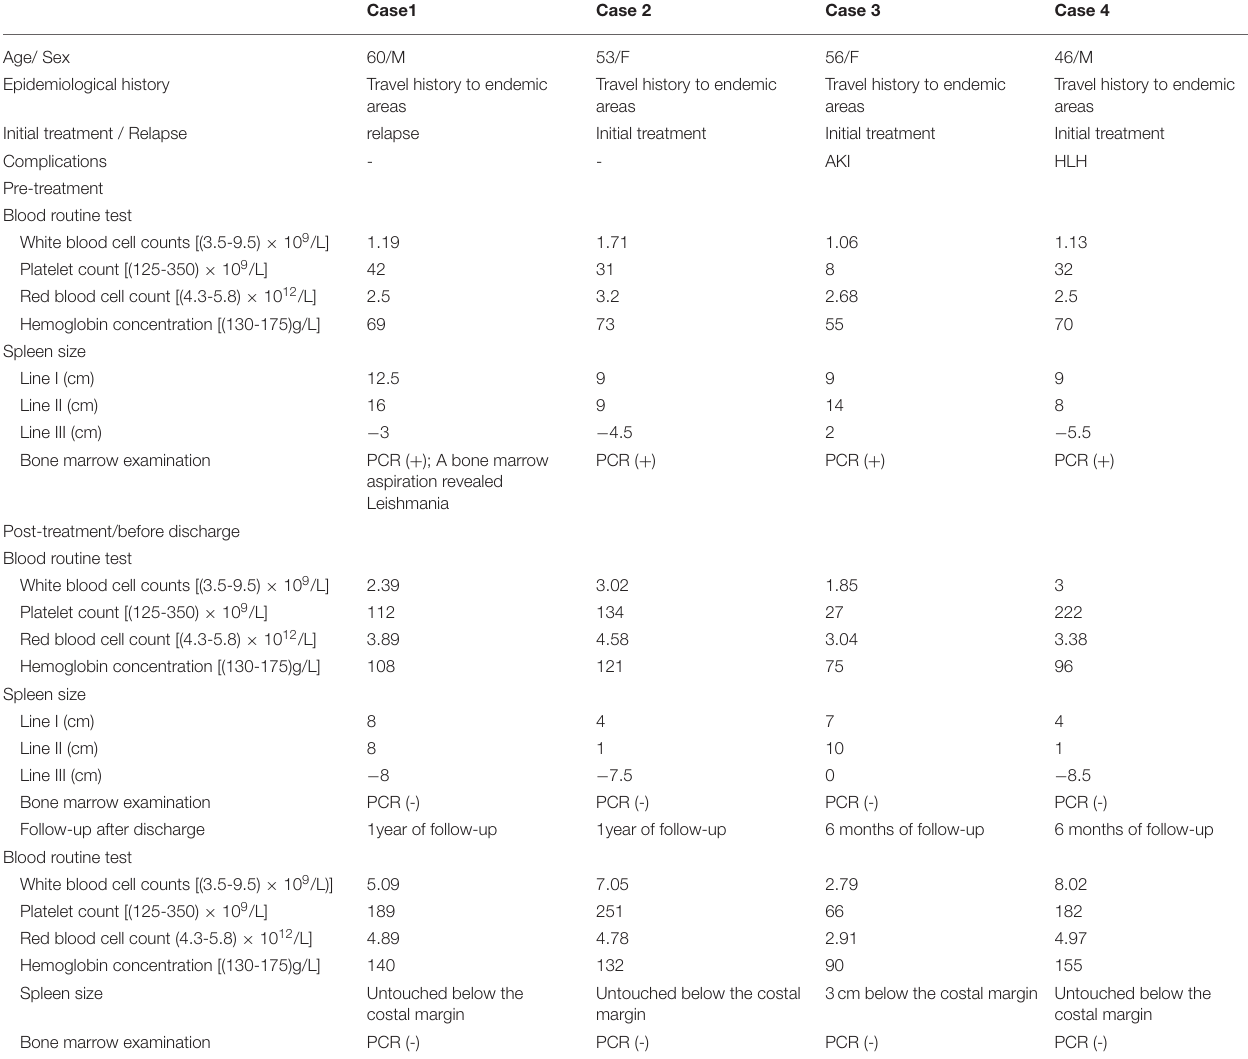
TABLE 1 | Basic patient information and examination results before and after treatment. Case1 Case 2 Case